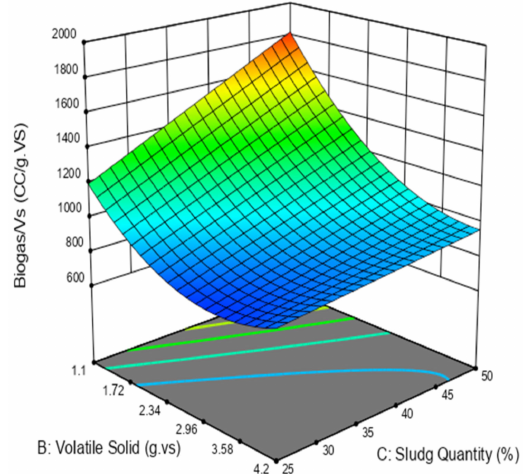
Figure 10. 3-D surface plot displays the effect of volatile solid and sludge quantity on Biogas/g-VS at 37 ◦